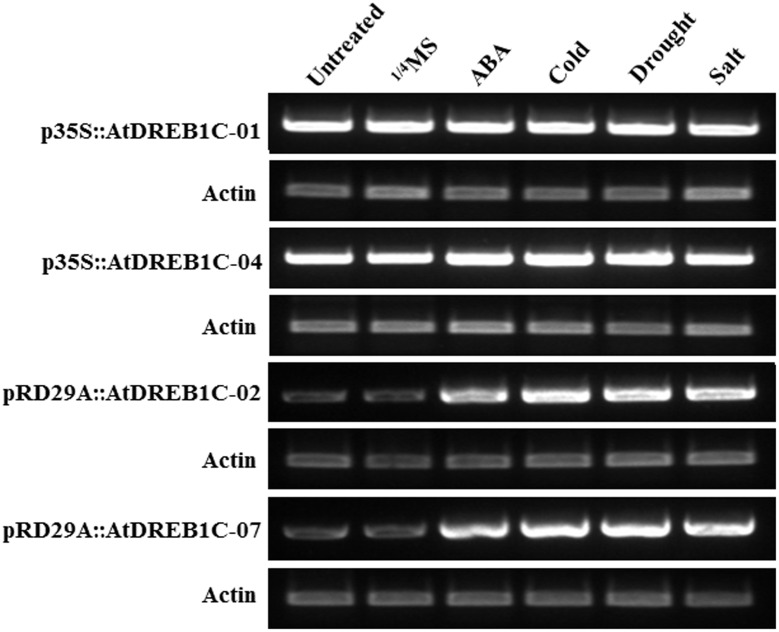
Induction of AtDREB1C expression under various conditions. ABA- and stress-induced AtDREB1C expression determined by RT-PCR. RNA was isolated from seedlings subjected to stress treatments as follows: 100 μM ABA (6 h), 250 mM NaCl (6 h), or 20% PEG6000 (6 h) in 1/4 Murashige and Skoog (MS) solution; cold (4°C, 6 h). Untreated indicates untreated control plants, and 1/4 MS indicates seedlings treated with 1/4 MS solution lacking supplements. The transgenic lines are indicated by the construct names followed by the line number: p35S::AtDREB1C-01 refers to p35S::AtDREB1C line 01 and so on.